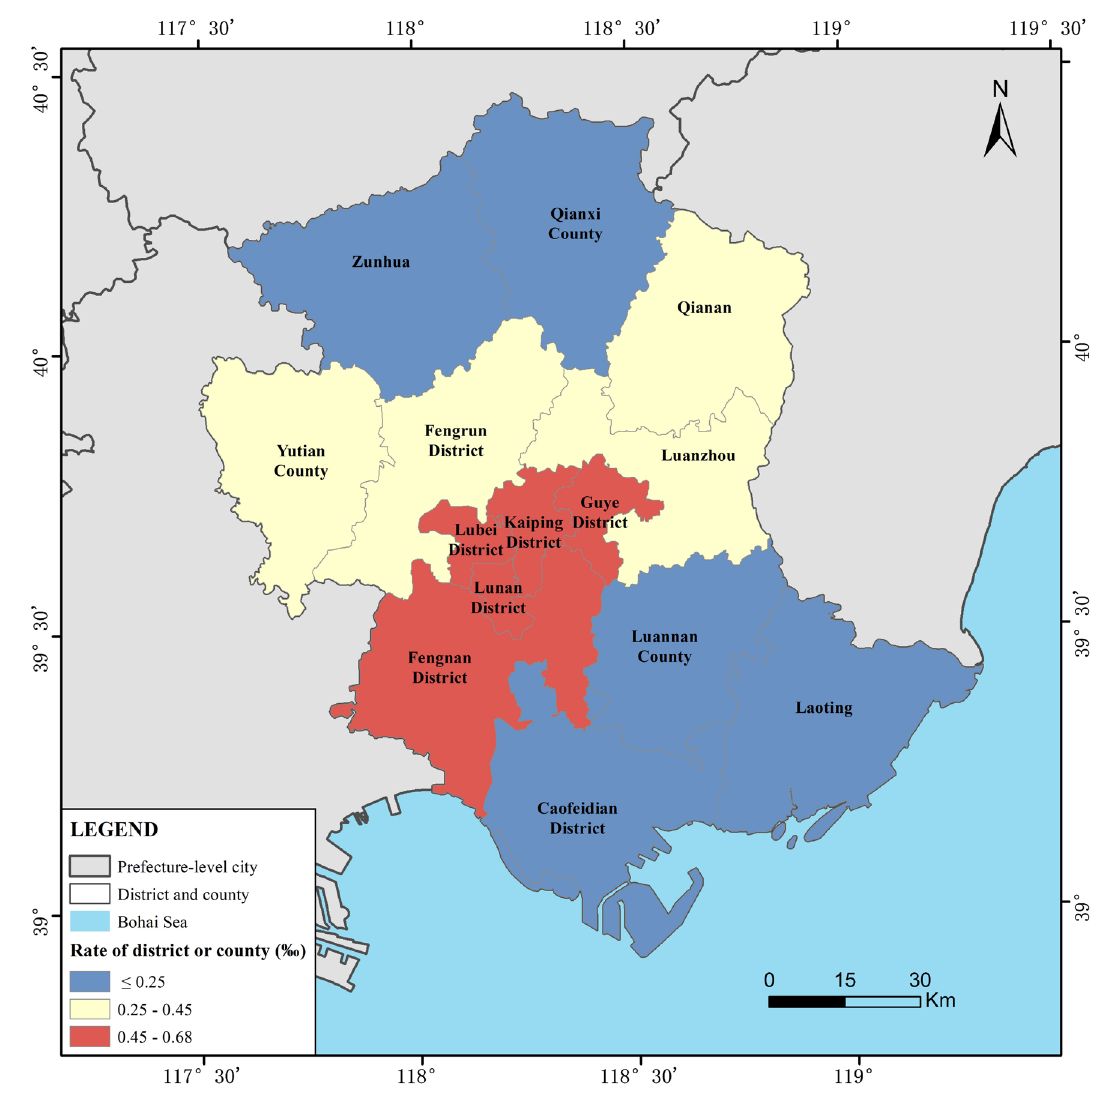
Fig. 7 Classification of rate value for districts and counties in Tangshan